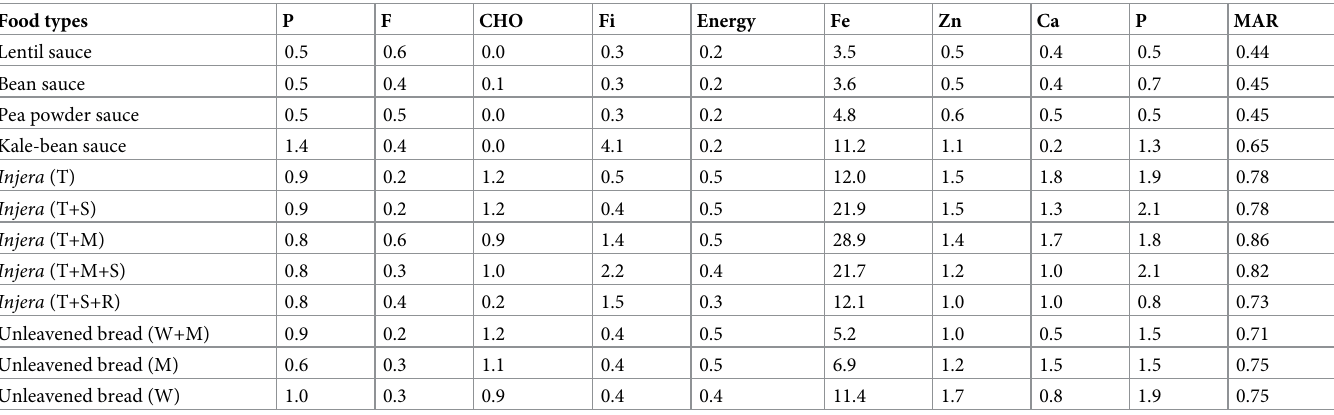
Table 8. Adequacy of the maternal foods in nutrients for meeting dietary